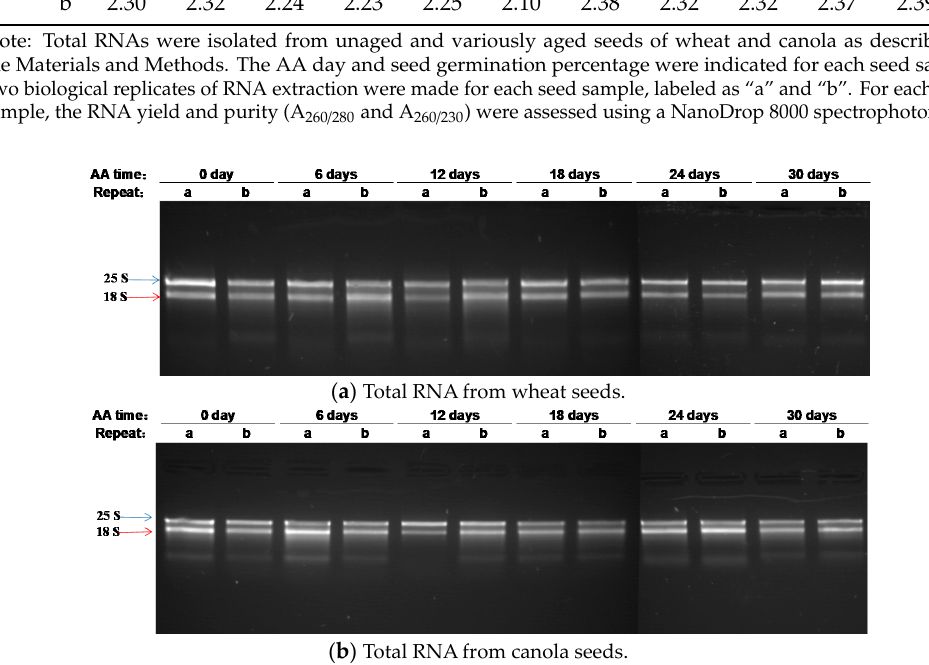
Figure 2. The integrity of total RNAs isolated from unaged and acceleratedly aged wheat ( a ) and canola ( b ) seeds. Total RNAs were isolated from dry seeds of wheat and canola, as shown in Figure 1 and described in the Materials and Methods. The AA days for the seeds are indicated at the top of the figure. There were six wheat or canola seed samples with two replicates of total RNAs labeled as a and b. The same amount of total RNA (0.5 µg) was loaded into each lane in the 1% agarose gel, which was subjected to electrophoresis.